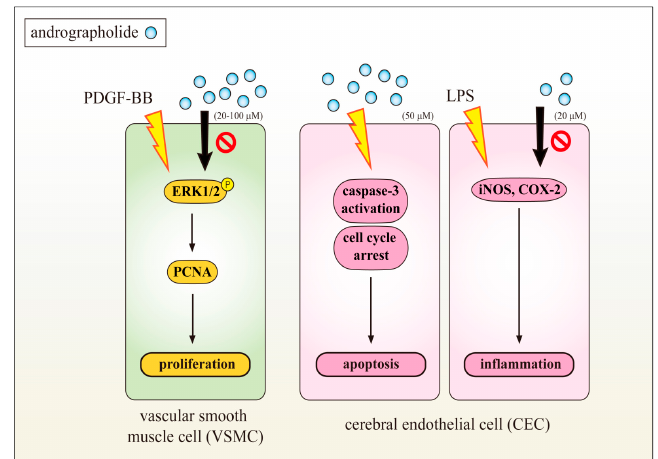
Figure 2. Andrographolide inhibited platelet-derived growth factor-BB (PDGF-BB) induced vascular smooth muscle cell (VSMC) proliferation via reducing extracellular signal-regulated kinase (ERK1/2), and inhibiting the expression of proliferating cell nuclear antigen (PCNA) in the G1 and S phases of